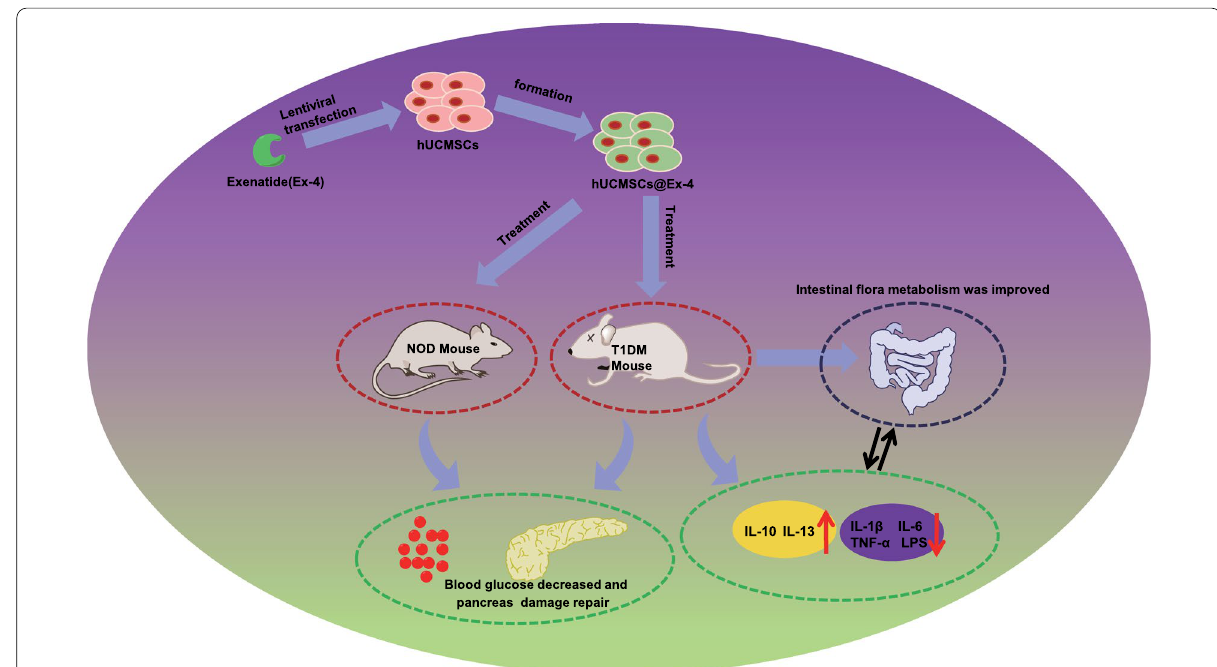
Fig. 6 Schematic representation of the regulatory network mechanisms of hUCMSCs@Ex-4 effects in T1DM. hUCMSCs@Ex-4 reduces the secretion of pro-inflammatory cytokines and modulates the abundances of pro-inflammatory intestinal bacteria, and promotes the secretion of anti-inflammatory cytokines, increasing the abundances of anti-inflammatory intestinal bacteria, thereby reducing blood glucose levels and promoting pancreatic islet tissue damage repair, ultimately alleviating of